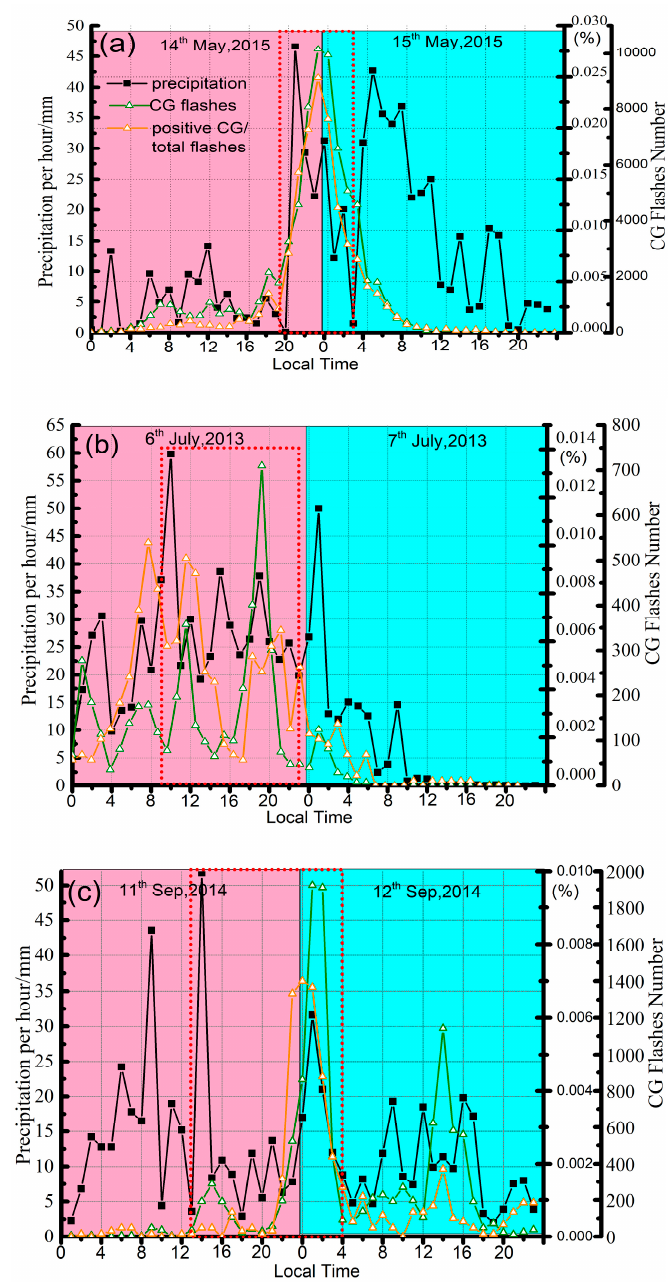
Figure 2. Temporal distribution of lightning and precipitation. ( a ) Case 1; ( b ) Case 2; ( c ) Case 3; red dotted box represents the region of precipitation peak and CG (Cloud to ground) lightning peak, in which the starting point and end point of red dotted box are 1 h before the peak of precipitation and 2 h after the peak of CG flashes, respectively.